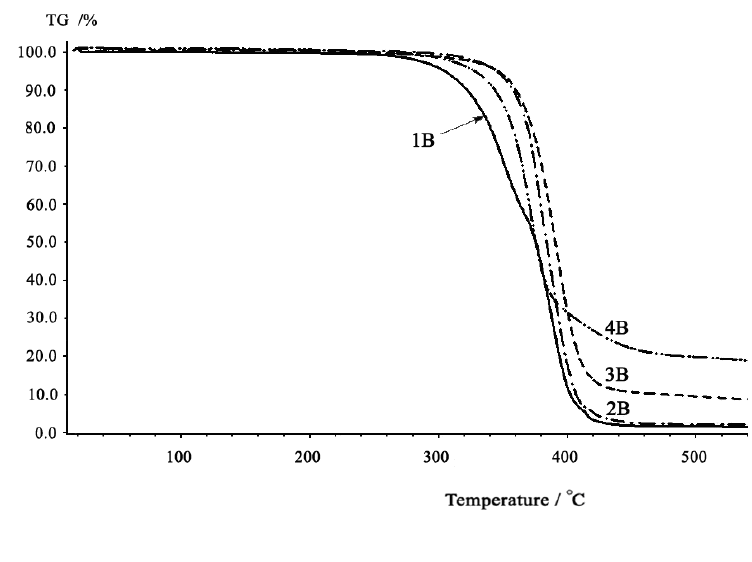
Figure 8. TGA thermograms of polycarbonates (Series B). TG % is the mass percentage of the polymer sample remaining after heating the polymer to a certain